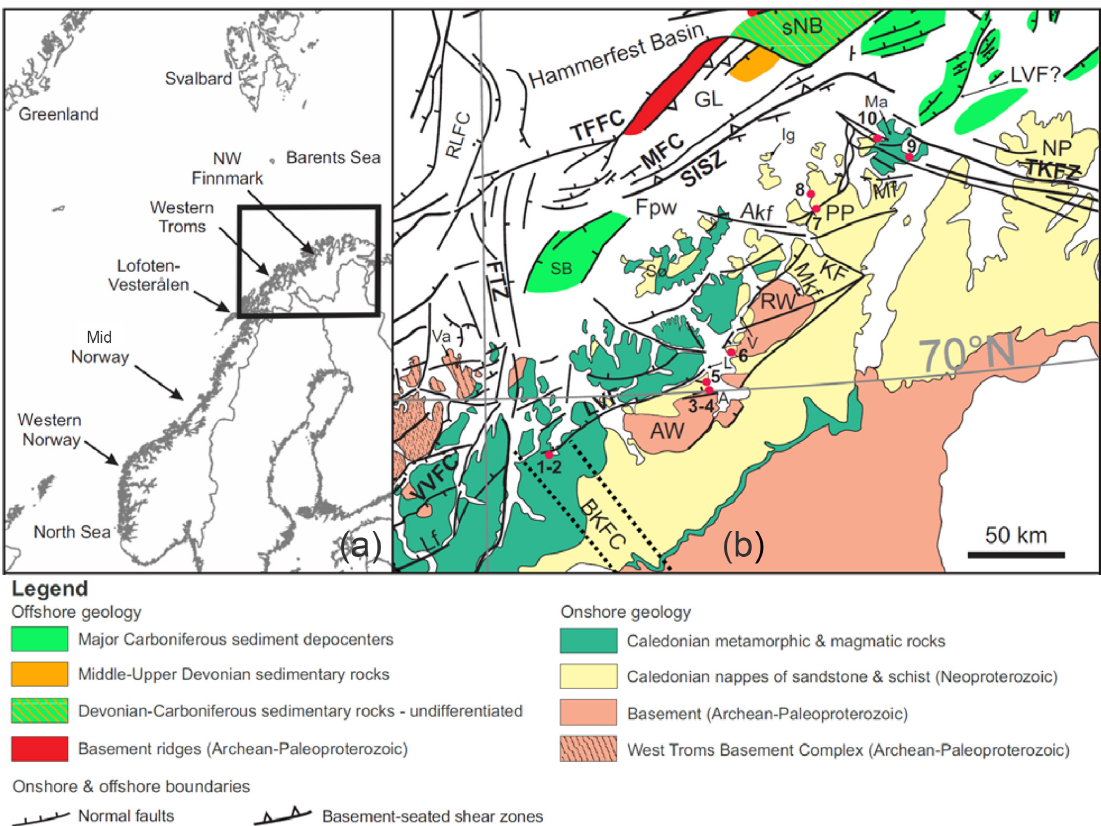
Figure 1. Panel (a) shows the location of the study area (NW Finnmark) along the Norwegian continental shelf as a black frame. Panel (b) shows a tectonic map of NW Finnmark showing the location of dated brittle faults as red dots numbered as follows: (1) is Sørkjosen 1; (2) is Sørkjosen 2; (3) is Altafjorden 1; (4) is Altafjorden 2; (5) is Talvik; (6) is Storekorsnes; (7) is Snøfjorden–Slatten; (8) is Porsanger; (9) is Honningsvåg; (10) is Gjesvær. Map is modified after Indrevær et al. (2013) and Koehl et al. (2018a). Abbreviations are as follows: A is Altafjorden; Akf is Akkarfjord fault; AW is Alta–Kvænangen tectonic window; BKFC is Bothnian–Kvænangen Fault Complex; FPw is western Finnmark Platform; FTZ is Fugløya transfer zone; GL is Gjesvær Low; Ig is Ingøya; KF is Kokelv Fault; L is Langfjorden; LVF is Langfjord–Vargsund fault; Ma is Magerøya; Mf is Magerøysundet fault; MFC is Måsøy Fault Complex; Mkf is Markopp fault; NP is Nordkinn Peninsula; PP is Porsanger Peninsula; RLFC is Ringvassøya–Loppa Fault Complex; RW is Repparfjord–Komagfjord tectonic window; SB is Sørvær Basin; SISZ is Sørøya–Ingøya shear zone; sNB is southwesternmost Nordkapp basin; Sø = Sørøya; TFFC is Troms– Finnmark Fault Complex; TKFZ is Trollfjorden–Komagelva Fault Zone; V is Vargsundet; Va is Vanna; VVFC is Vestfjorden–Vanna fault